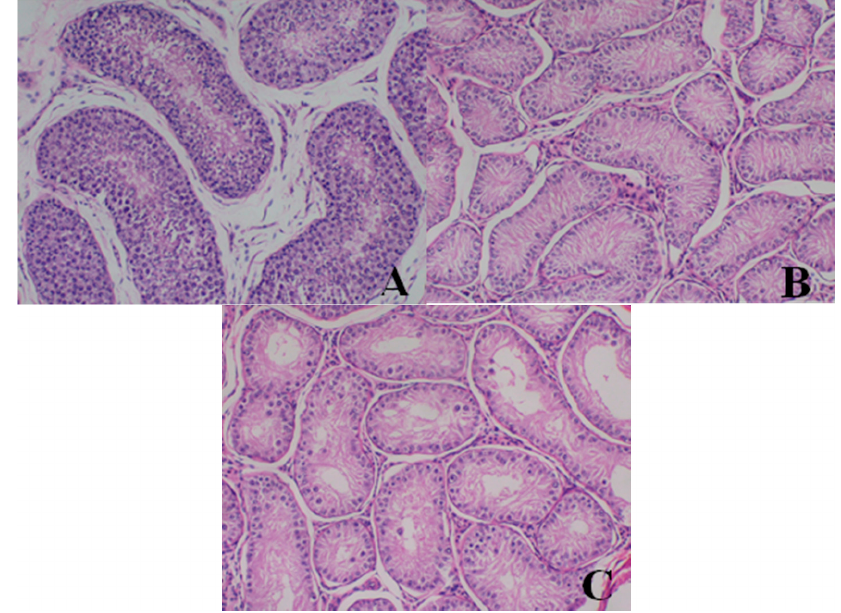
Figure 5. Hematoxylin and eosin-stained histologic sections of dogs’ testes ( A – C ) (original magnification × 100). ( A ) Histopathological photomicrograph of testis from 29 belong to the control ♂ group at d28: normal; ( B ) testis from 5 belonging to the 80-mg/kg dose group at d28; ( C ) testis from ♂ 23 belonging to the 40-mg/kg dose group at d28. Note that the tubule lumen decreased, and the ♂ numbers and types of spermatogenic cells were reduced. Images captured from sections prepared from the necropsy of dogs euthanized at